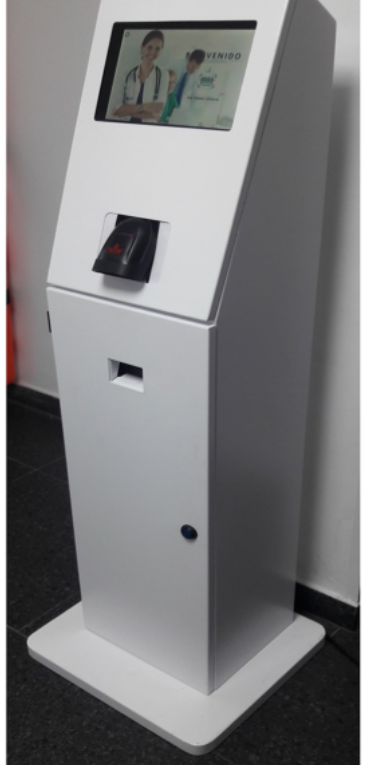
Figure 3. Primary care waiting room kiosk used for the screening of depression and alcohol use